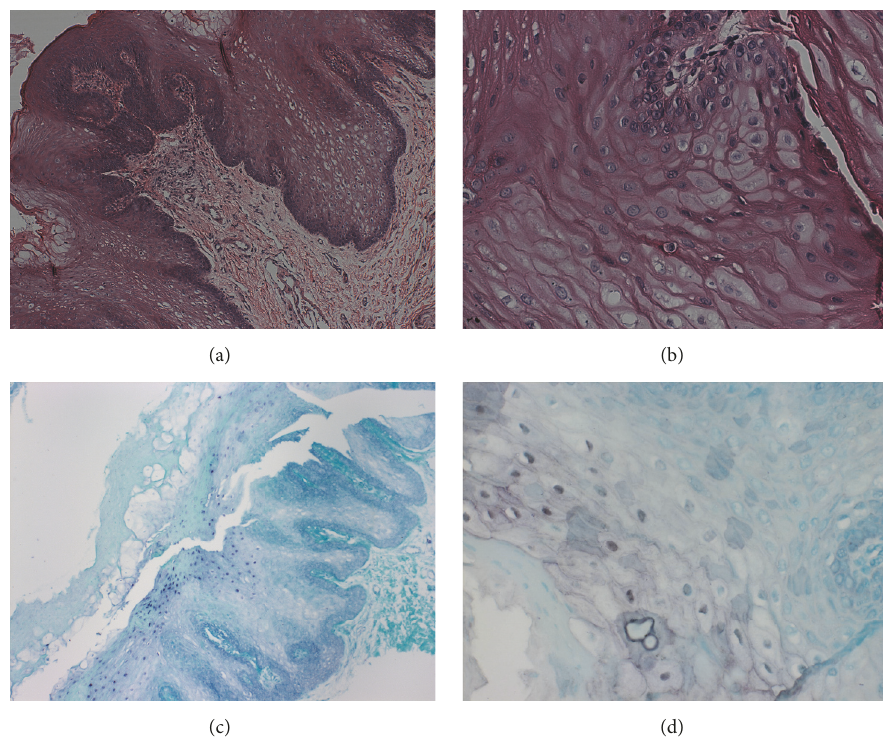
Figure 2: Histological characteristics of OHL and in situ hybridization reaction. (a) Histopathological section, stained with H&E, showing stratified squamous epithelium, acanthosis, epithelial hyperplasia, cells resembling koilocytes, cells with opaque nucleus, and perinuclear halo (100x magnification). (b) Section stained with H&E showing cells resembling koilocytes (400x magnification). (c) In situ hybridization reaction with positivity for EBV (100x magnification). (d) In situ hybridization reaction with positivity for EBV (400x magnification). Table 1: Comparison between presence of oral hairy leukoplakia and quantitative variables of the patients.